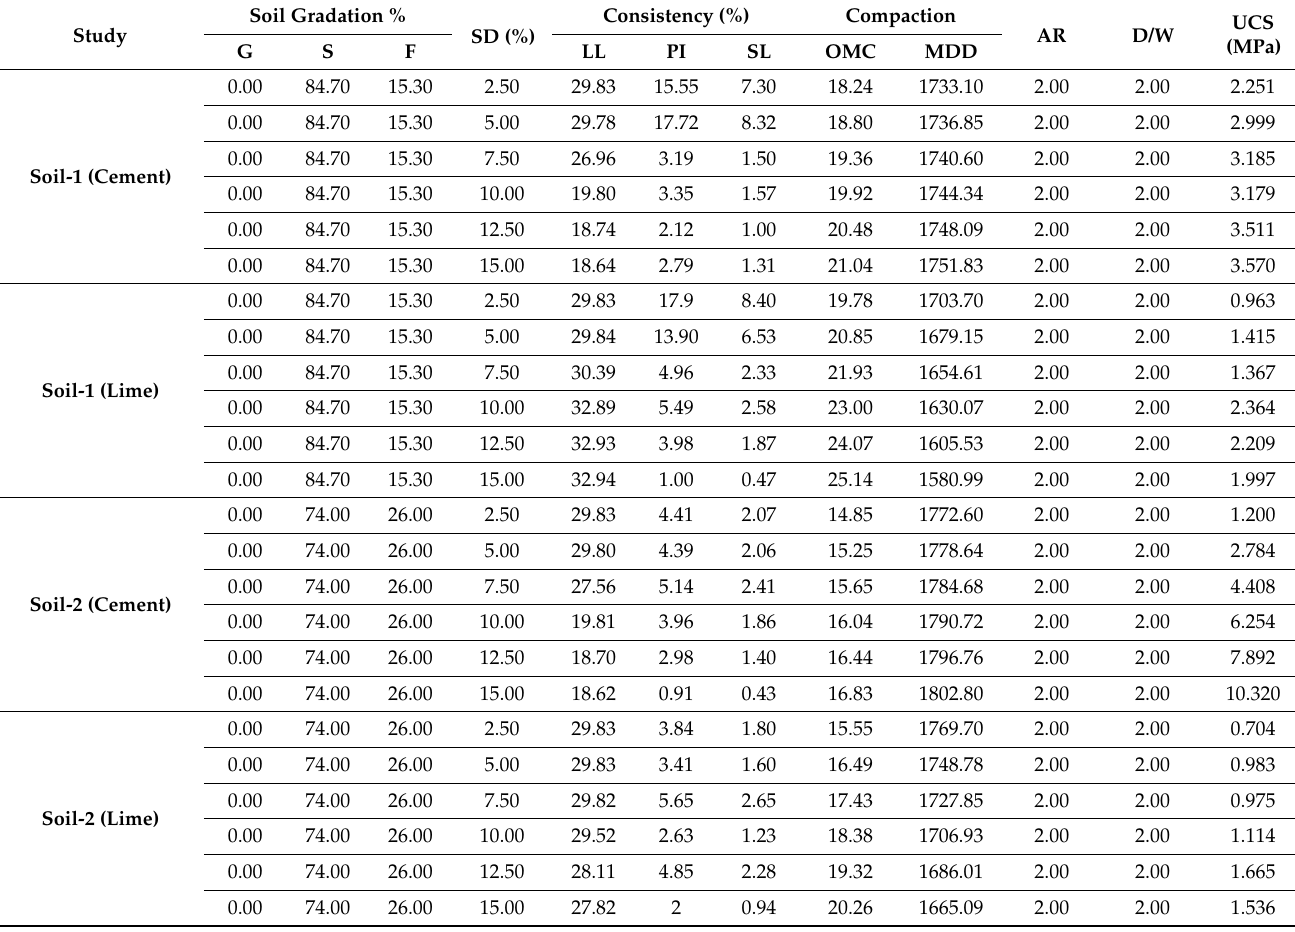
Table 10. Experimental results for model